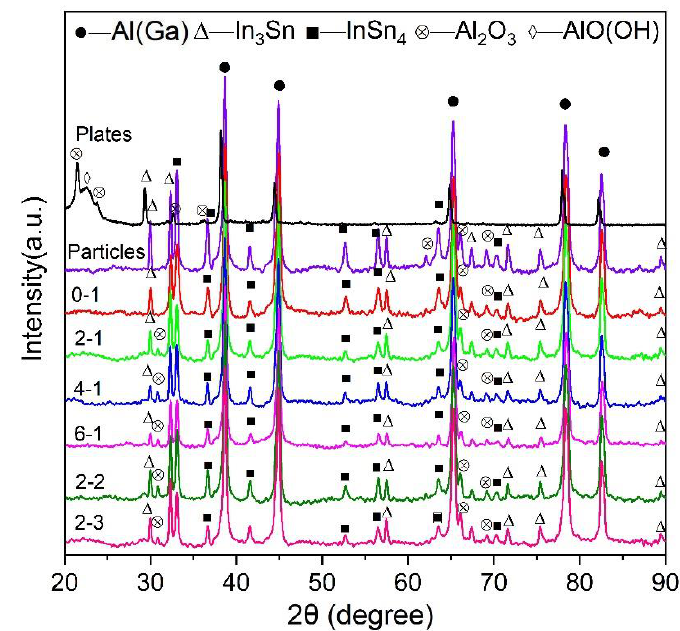
Figure 2. XRD patterns of the Al-LMP alloy plates, powders, and Al-LMP-NiCl 2 composites.